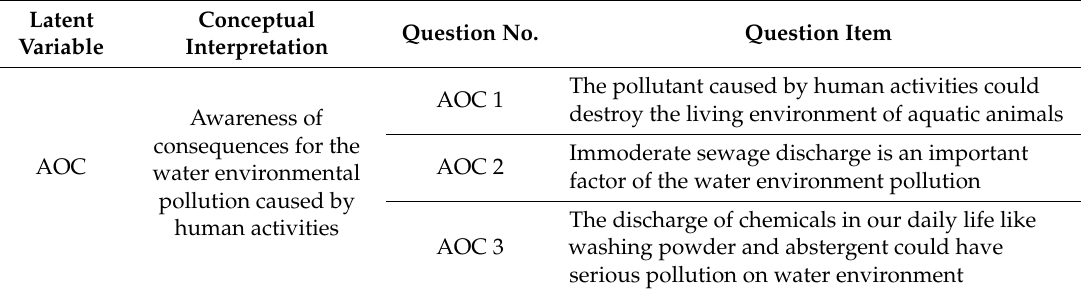
Table 4. Measurement table for